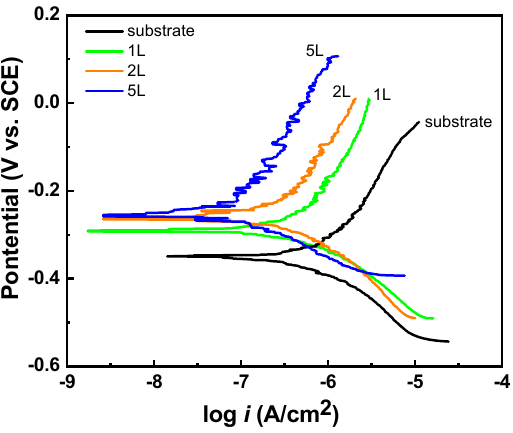
Figure 6. Potentiodynamic polarization curves of the substrate, and 1L, 2L, 5L modified zaccagnaite films measured in a 3.5 wt.% NaCl solution. Table 2. Corrosion potential ( E corr ), corrosion current densities ( i corr ), and LPR polarization re- sistance ( R p ) measured for all samples in a 3.5 wt.% NaCl solution (n = 3). Sample